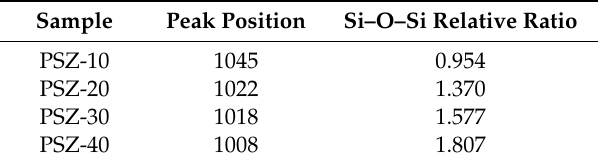
Table 1. Si–O–Si asymmetric stretching band shift and relative intensity of the Si–O–Si peaks.